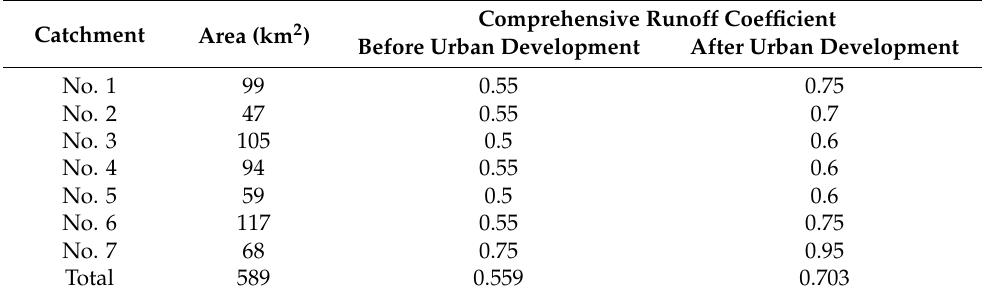
Figure 1. Gucheng Lake catchment area and its subregion. Table 1. The underlying surface of each catchment area of Gucheng Lake. Comprehensive Runoff Coefficient Catchment Area (km 2 ) Before Urban Development After Urban